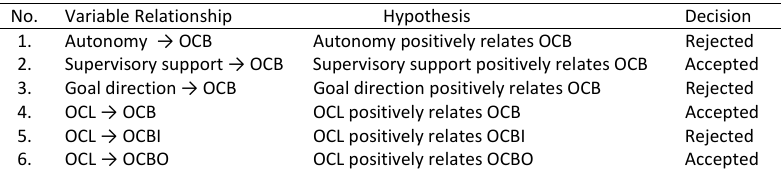
Table 5: Summary of the study variables Table 5. Summary of the study